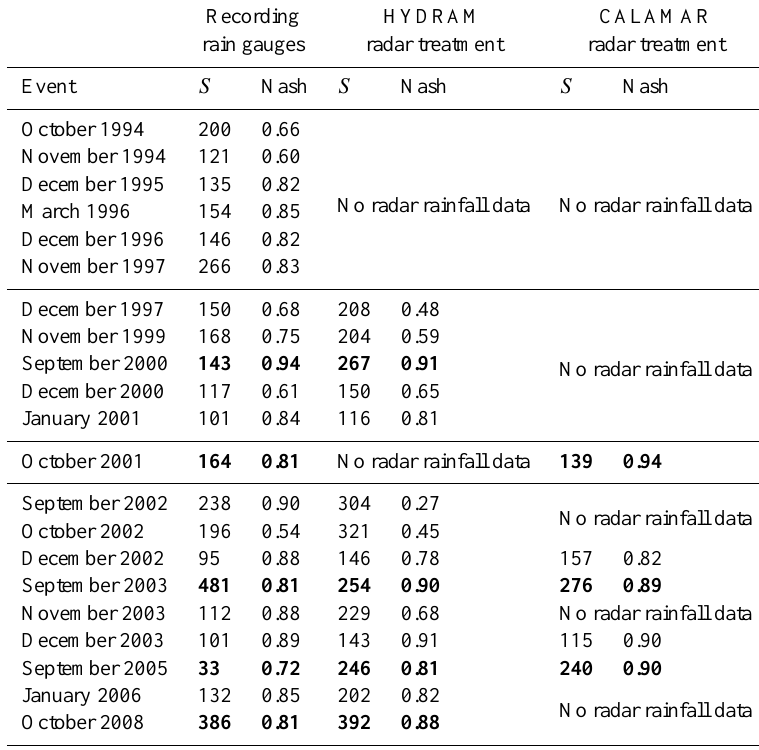
Table 4. Initial condition and Nash criterion obtained with recording rain gauge and radar rainfall inputs with ds = 0.28d − 1 ; w = 101mm; V 0 = 1 . 3ms − 1 ; K 0 = 0 .